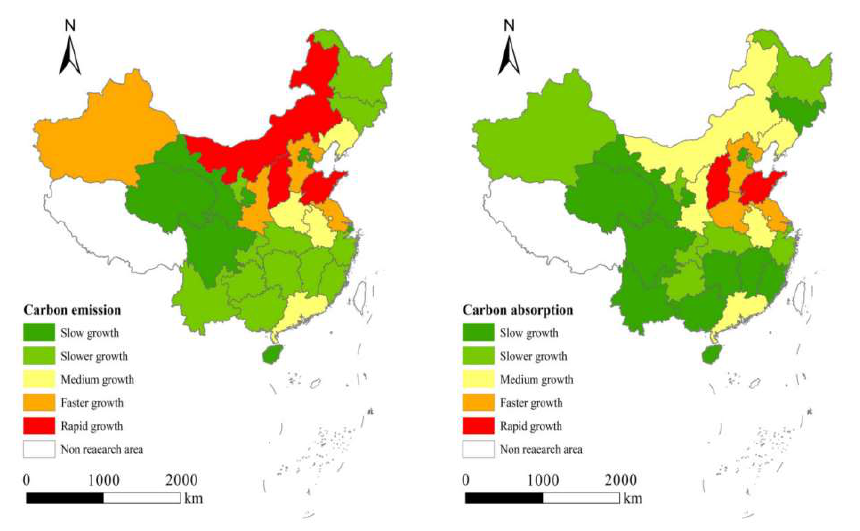
Figure 1. Growth level of carbon emissions and total carbon absorption in provinces from 2003 to 2016 (Huang, H. [7]).